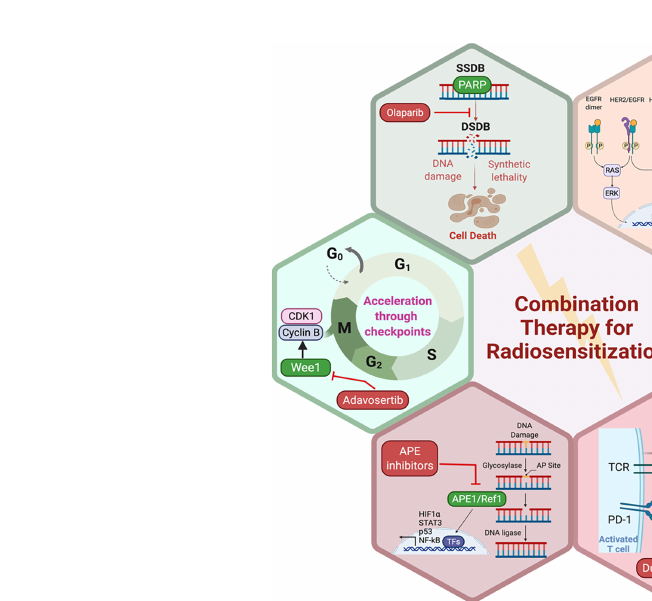
FIGURE 2 | Potential pathways and representative small molecule inhibitors of the key proteins in those pathways with potential to enhance the sensitivity of tumor cells to RT. Created in